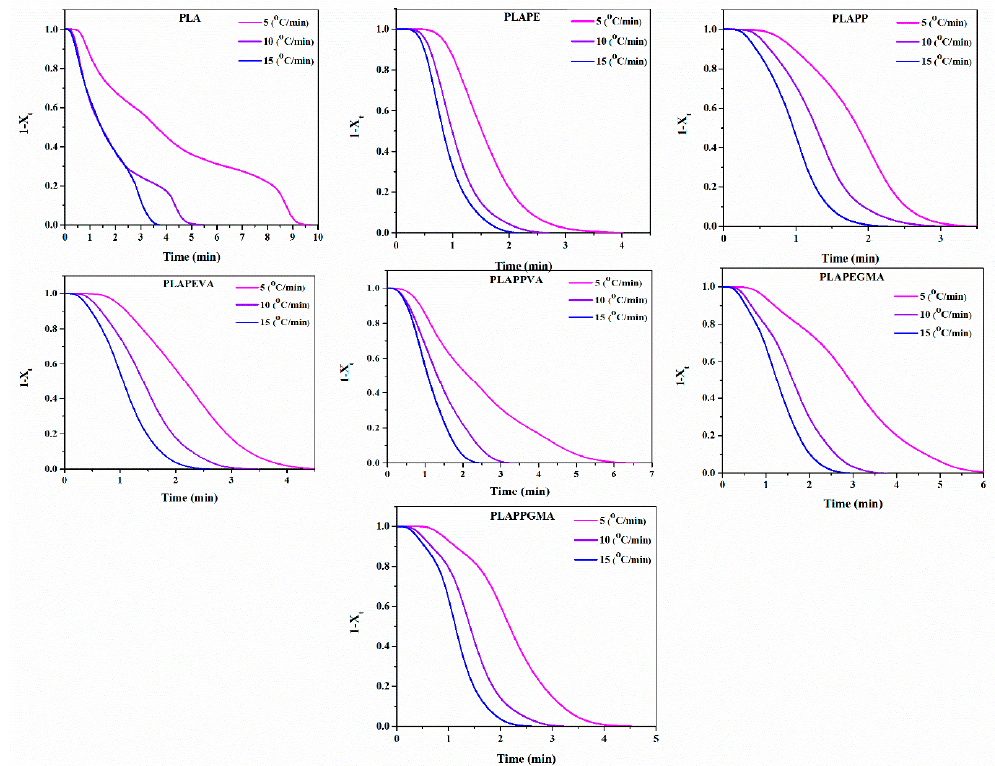
Figure 6. Variation of (1 − (cid:1850) (cid:3047) ) as a function of time for the neat PLA and PLA/POE (80/20) with and without compatibilizer. Compatibilizers, EVA and EMA-GMA, were used at 4% phr.